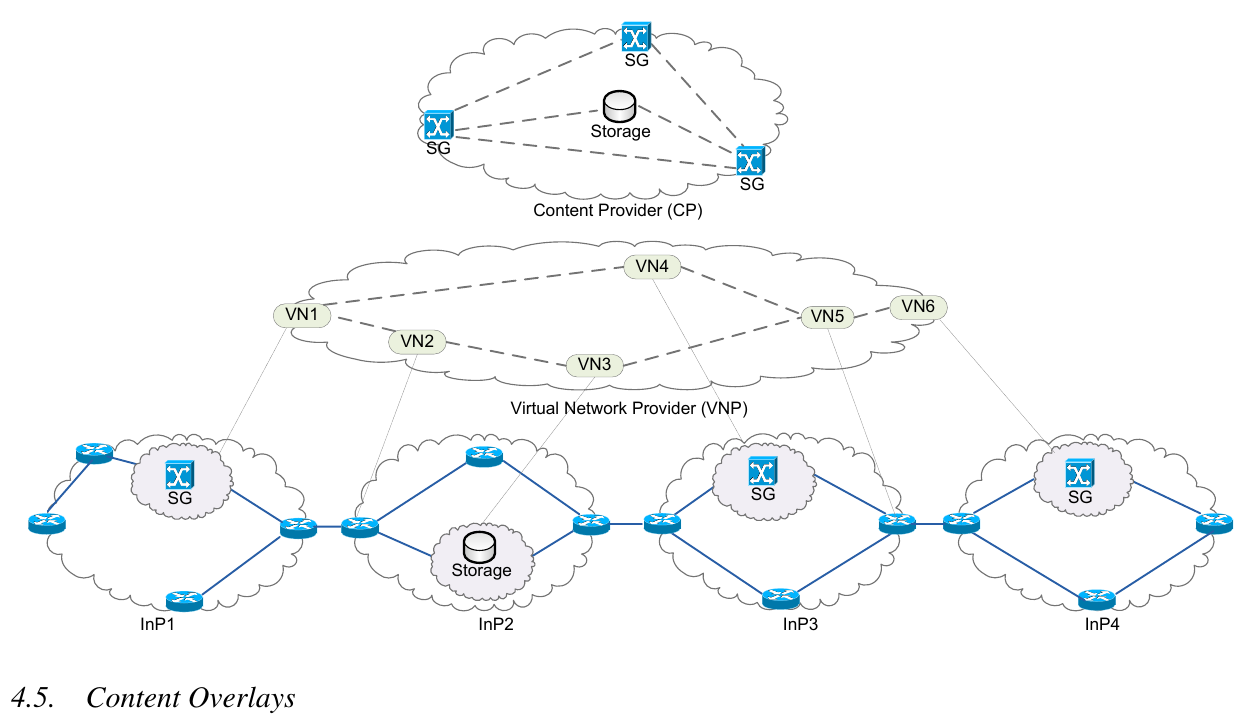
Figure 5. Roles and operation of the content distribution